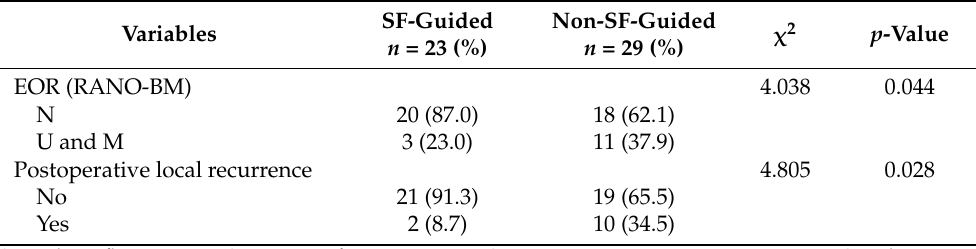
Table 2. Comparison of extent of resection (EOR) and postoperative local recurrence. Variables